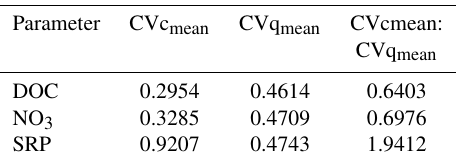
Table 2. Coefficients of variation (spatial variability among catch- ments) of flow-weighted mean concentration (CVcmean) and mean stream flow (CVqmean), and the value of their ratio, for dissolved organic carbon (DOC), nitrate (NO 3 ), and soluble reactive phospho- rus